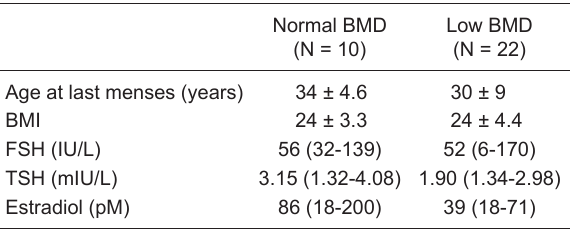
Data are reported as means ± SD (ANOVA) or median and in - terquartile range (Kruskal-Wallis test). No statistical differences were detected. BMD = bone mineral density; BMI = body mass index; FSH = follicle-stimulating hormone; TSH = thyroid-stimu - lating hormone; Low BMD = lumbar and/or femur osteopenia or osteoporosis.